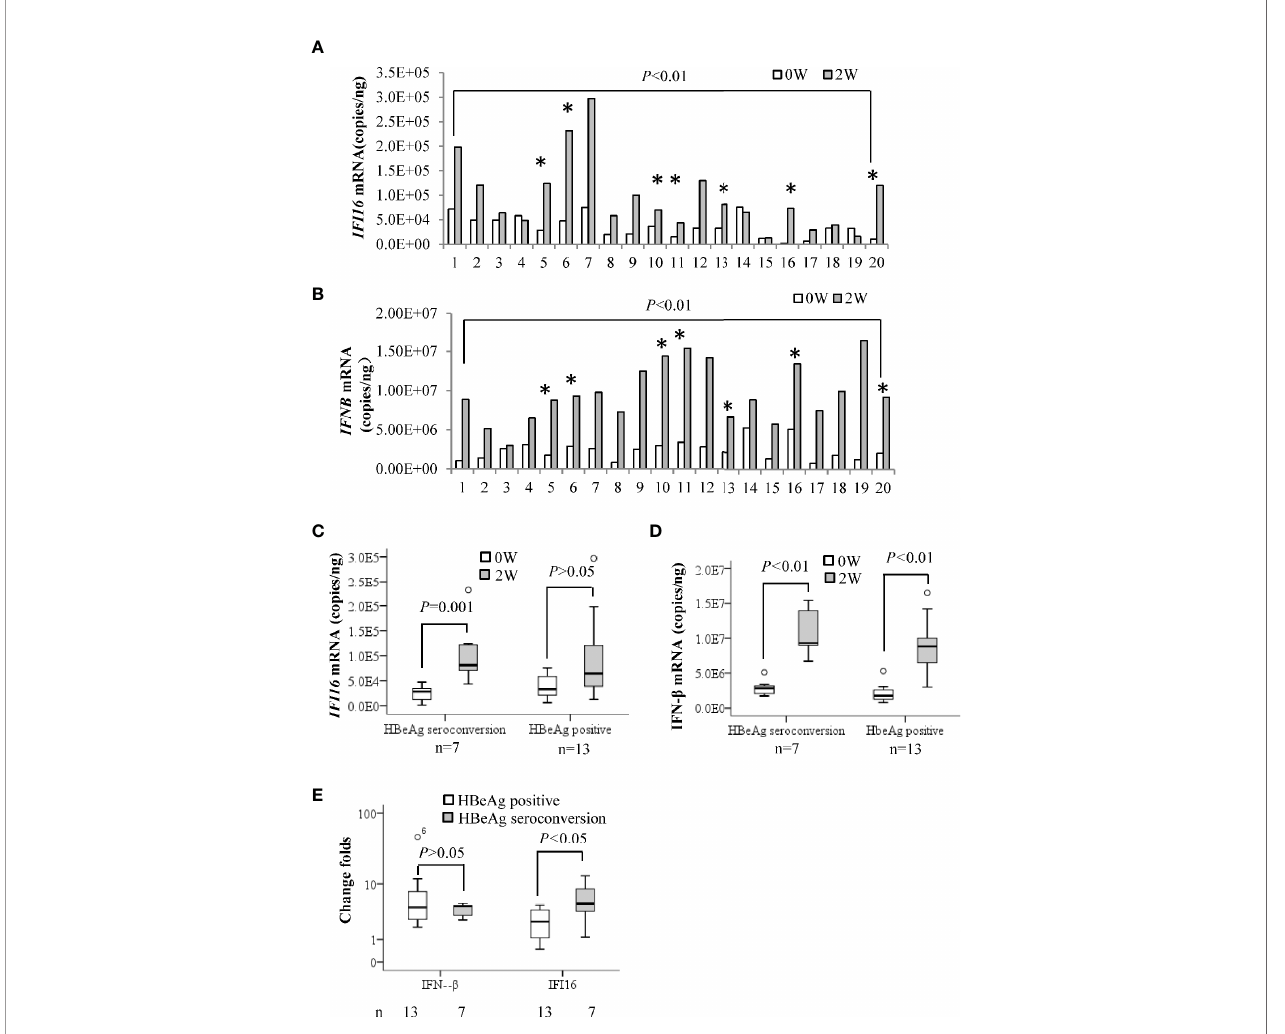
FIGURE 2 | Early changes in IFI16 mRNA of PBMCs in patients with CHB treated with interferon. Quanti fi cation of IFI16 mRNA (A) and IFN- b mRNA (B) in peripheral blood mononuclear cells (PBMCs) at baseline and two weeks after Peg-IFN- a 2b treatment were comparatively analyzed by a paired Student ’ s t-test. * Indicates patients achieving HBeAg seroconversion at 24 weeks follow-up after Peg-IFN- a 2b therapy. The IFI16 mRNA (C) and IFN- b mRNA (D) changes in the patients with or without HBeAg seroconversion were tested by performing a Mann-Whitney U test. The patients were grouped according to HBeAg seroconversion. The difference in change folds of IFI16 mRNA and IFN- b mRNA after 2 weeks of interferon treatment were compared using a Mann-Whitney U test (E) . P < 0.05 was considered statistically signi fi